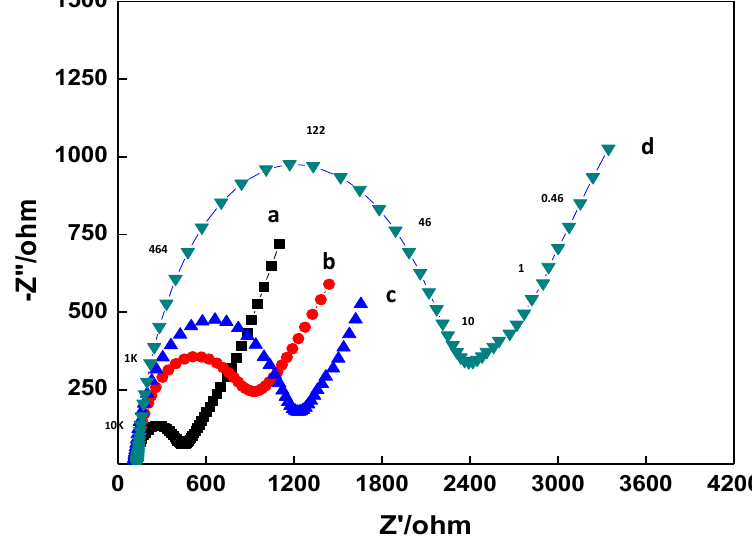
Figure 2. Electrochemical Impedance Spectroscopy (EIS) characterization of different modified electrodes: ( a ) bare glassy carbon electrode (GCE); ( b ) DNA/chitosan/Fe O /GCE; 3 4 ( c ) DNA/chitosan/GCE; and ( d ) DNA/chitosan/Fe O /HRP/GCE in 0.1 M KCl solution 3 4 containing 5 mM [Fe(CN) ] 3−/4− . Applied potential was set at 170 mV vs. Ag/AgCl (formal 6 potential of [Fe(CN) ] 3−/4− ) with the frequency range from 0.01 to 100,000 Hz with the 6 amplitude of 8 mV. Representative frequencies are as indicated in curve ( d